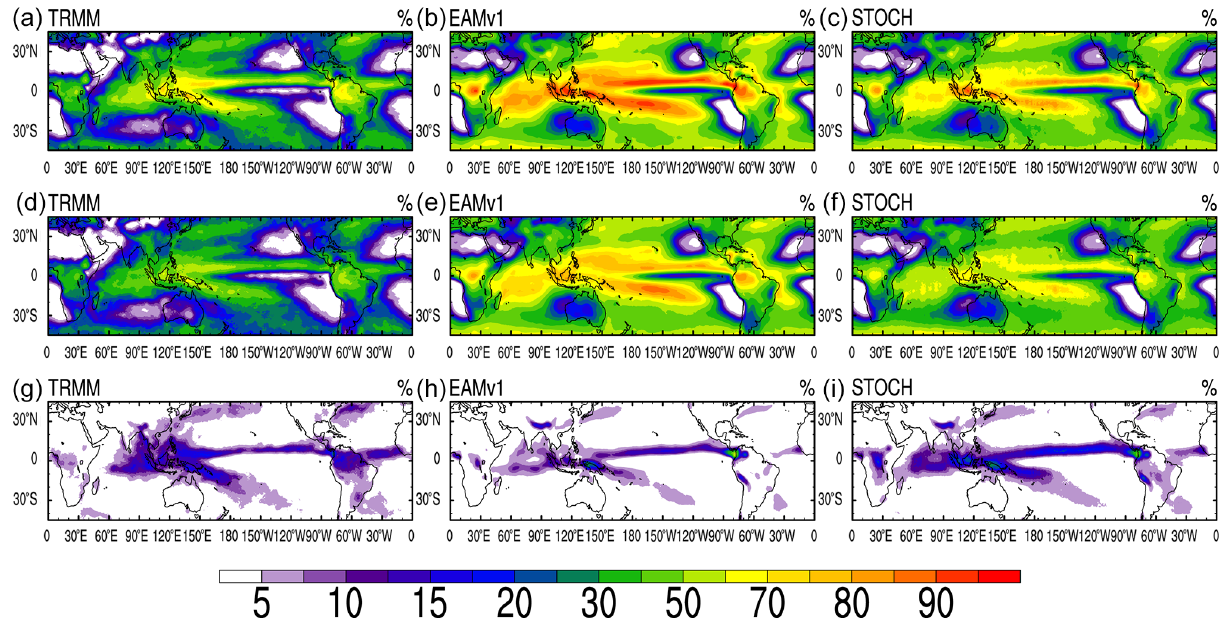
Figure 5. Spatial distributions of the frequencies of total rainfall intensity larger than (a–c) 1mmd − 1 , (d–f) between 1 and 20mmd − 1 , and (g–i) larger than 20mmd − 1 for TRMM, EAMv1 and STOCH, respectively.